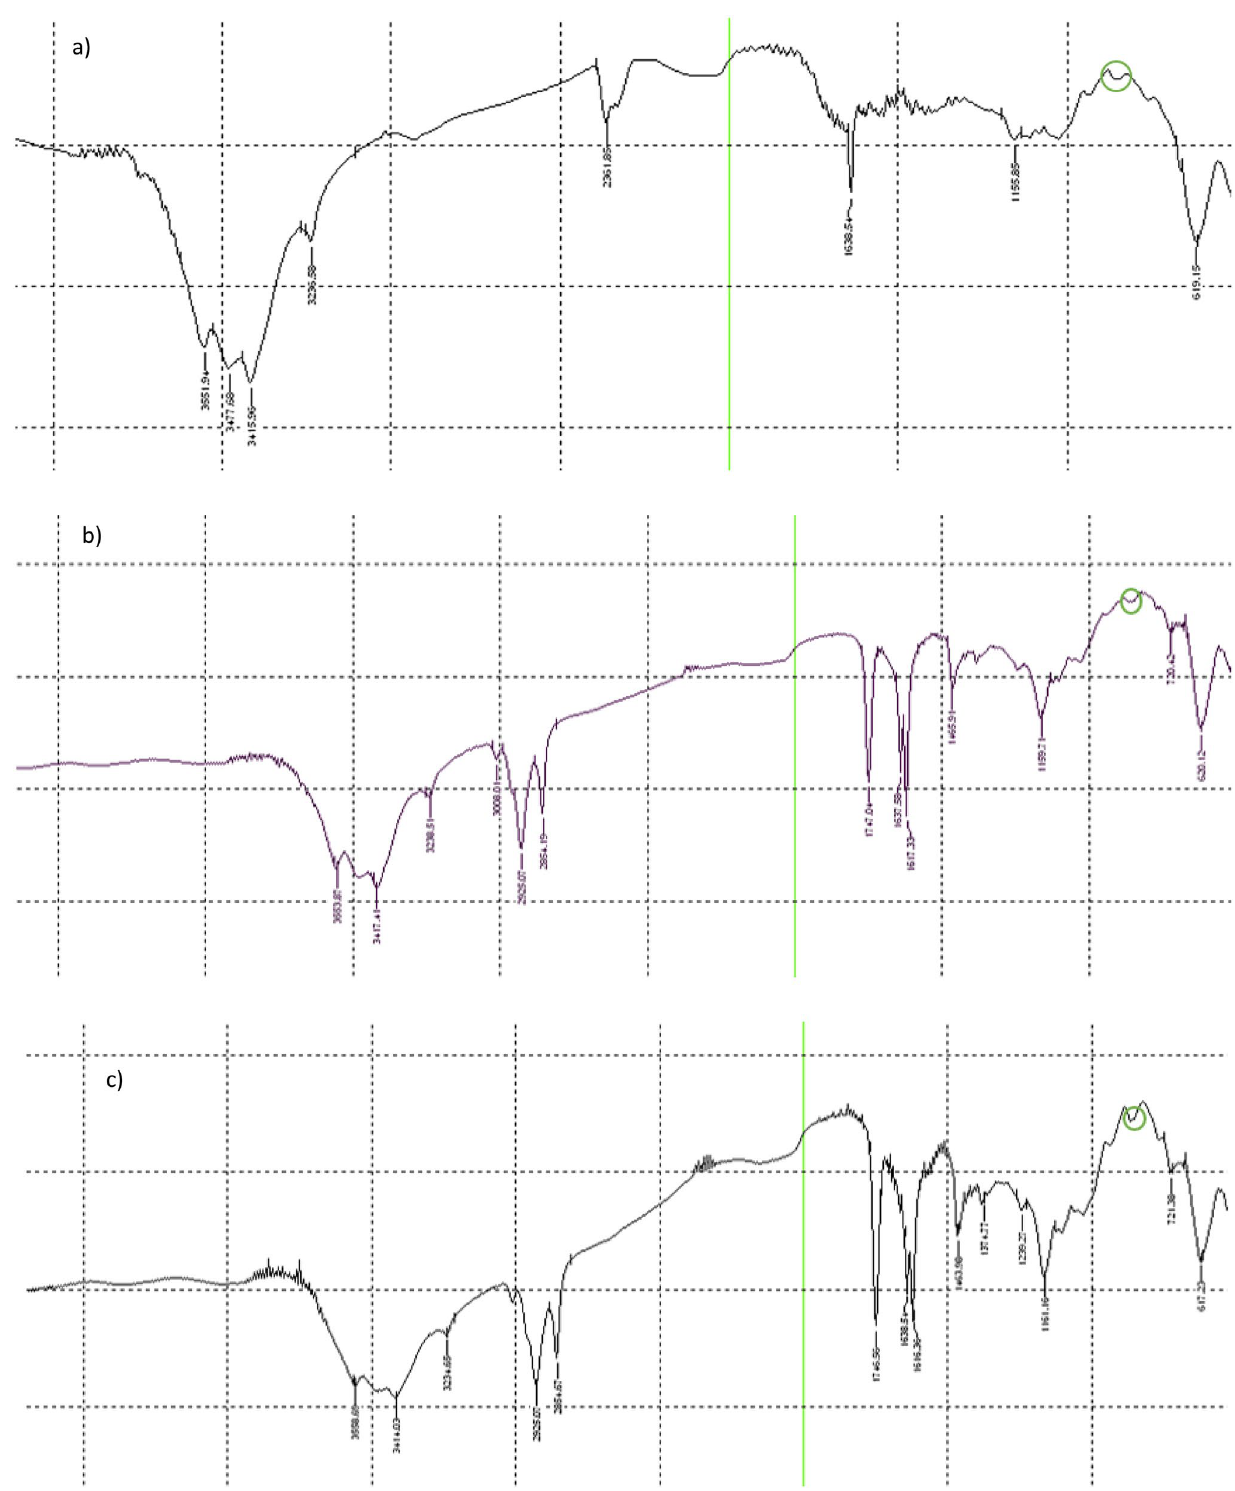
Fig. 1 Infrared spectra of FTIR analysis of Samples 1 to 5. a Sample 1 (Only starch). b Sample 2 [Starch with 2% Sodium Hydroxide and 2% Adipic Acid (on the weight of starch)]. c Sample 3 [Starch with 2% Sodium Hydroxide and 2% Adipic Acid and 1% Mustard Oil (on the weight of starch)]. d Sample 4 [Starch with 2% Sodium Hydroxide and 1% Adipic Acid and 1% Mustard Oil (on the weight of starch)]. e Sample 5 (Starch with 1% Adipic Acid and 1% Mustard Oil (on the weight of